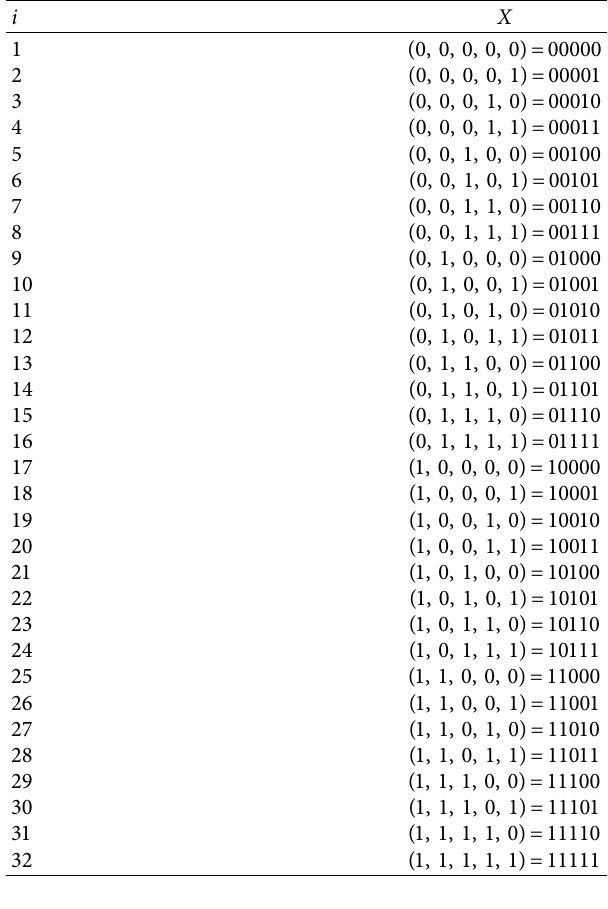
Table 6: All state vectors generated from (0, 0, 0, 0, 0) using the